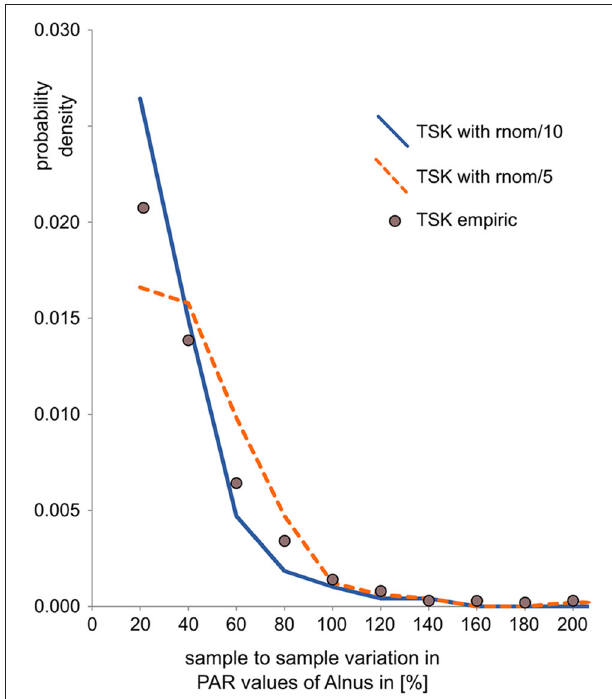
FIGURE 2 | Comparison of sample-to-sample variation (as an indicator of noise) in empiric and synthetic PAR records. Sample-to-sample variation is calculated as the relative difference between two consecutive PAR values, here for Alnus. The values, plotted as probability density, show that noise in the empiric PAR record from Lake Tiefer See is somewhat larger than in the derived synthetic PAR record with intermediate error added (TSK with rnom/10) and somewhat smaller than in the derived PAR record with large error added (TSK with